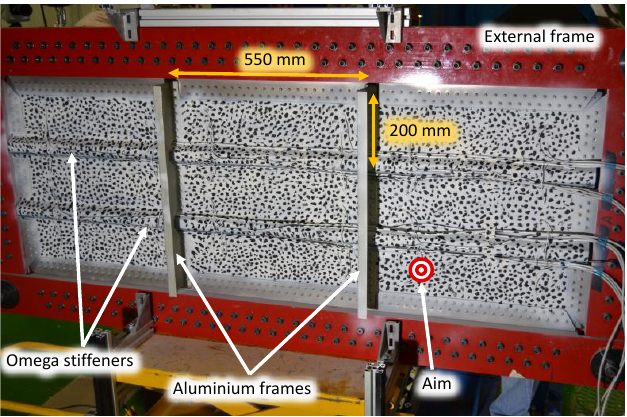
Figure 1. Carbon-fiber-reinforced polymer (CFRP) aeronautical panel employed to evaluate its modal behavior after multi-impact excitation using high-speed 3D digital image correlation (HS 3D-DIC).